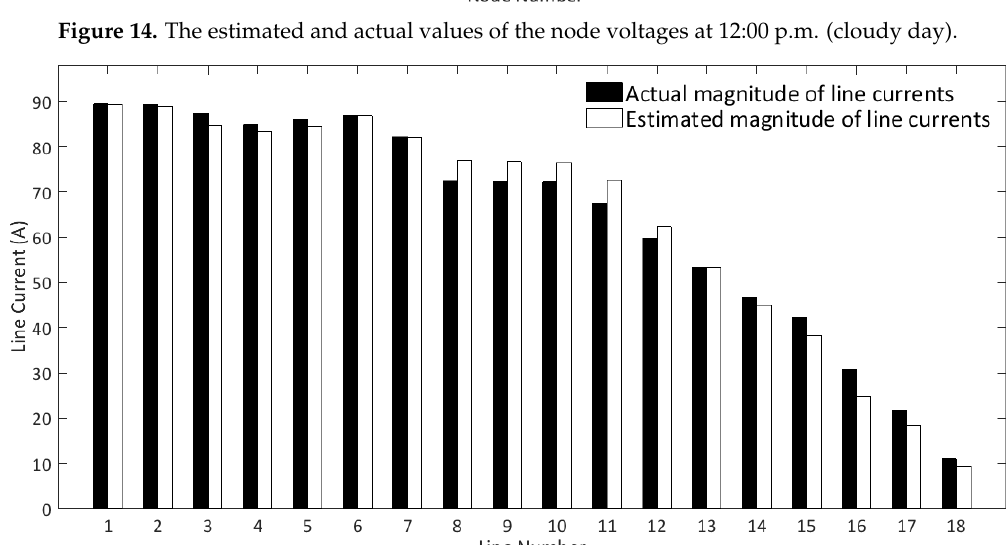
Figure 14. The estimated and actual values of the node voltages at 12:00 p.m. (cloudy day).